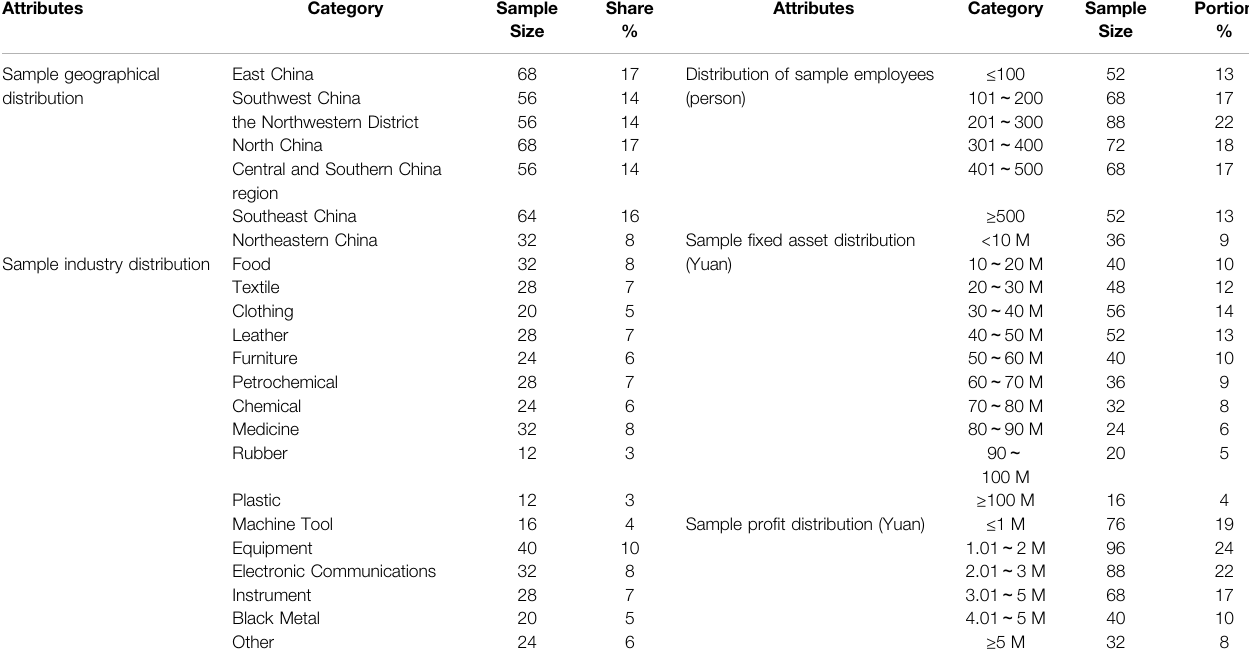
TABLE 1 | Sample characteristics.